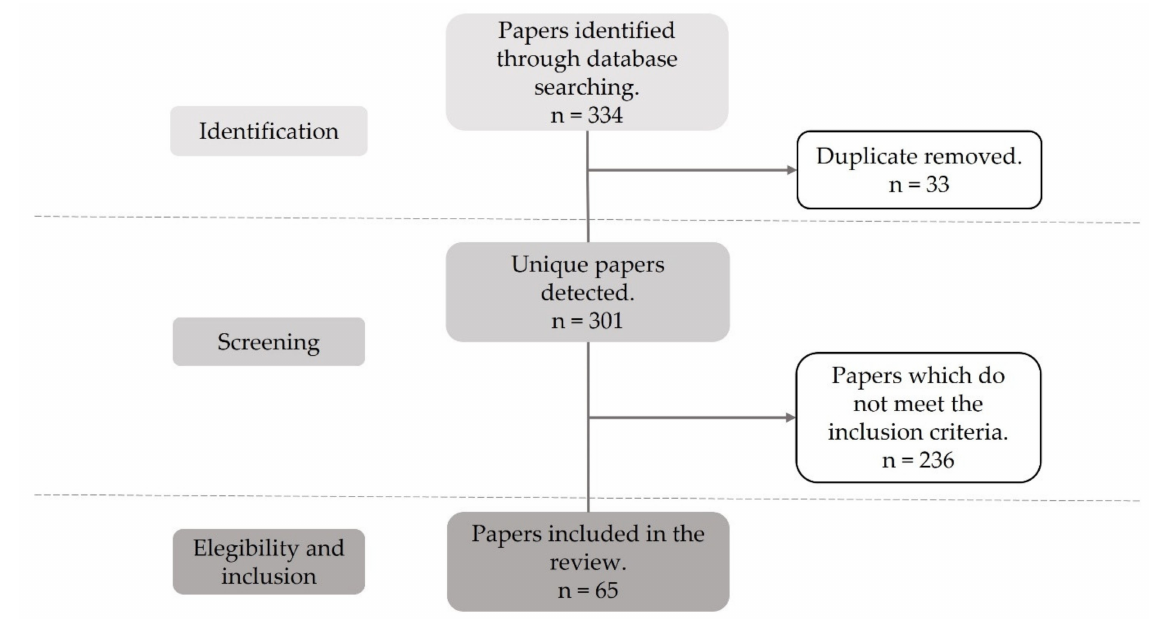
Figure 2. PRISMA flow